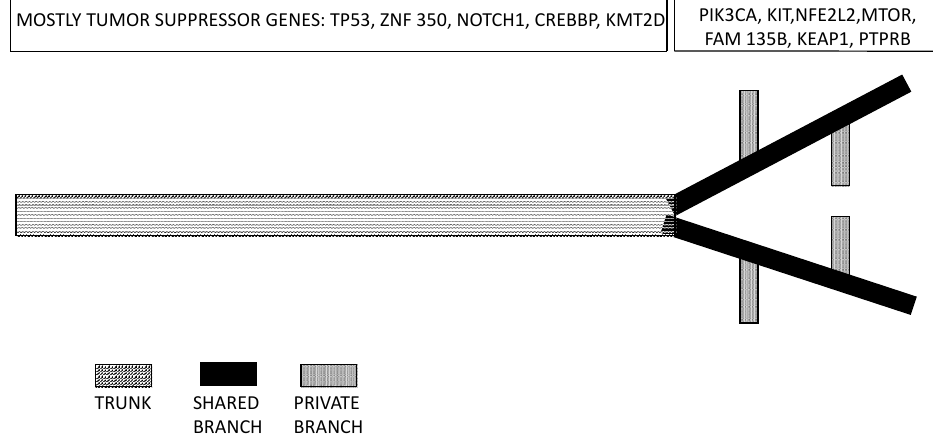
Figure 4. Intra ‐ tumor heterogeneity of somatic mutations in ESCCs, as evaluated by multiregion whole ‐ exome sequencing. The analysis of the mutational spectrum observed in different tumor regions allows the construction of a phylogenetic tree indicating the tumor evolution. In these phylogenetic trees, variable from one tumor to another, the trunk is defined as the initial clone, at the level of which are observed the initial genetic driver events responsible for tumor development; from this initial trunk, one or more branches are derived, maintaining some of the typical driver events observed in the trunk; finally, from the shared branches, one or more private branches may derive, characterized by the presence of mutations observed only in this tumor region. The result of this intra ‐ tumor evolutionary process consists in an increase of tumor heterogeneity and by the development of a process generating multiple tumor regions with different biologic properties from a single initial tumor. On the top are reported the genes most frequently altered during the initial (trunk) and later (shared and private branches) phases of spatial ‐ temporal development of ESCCs.